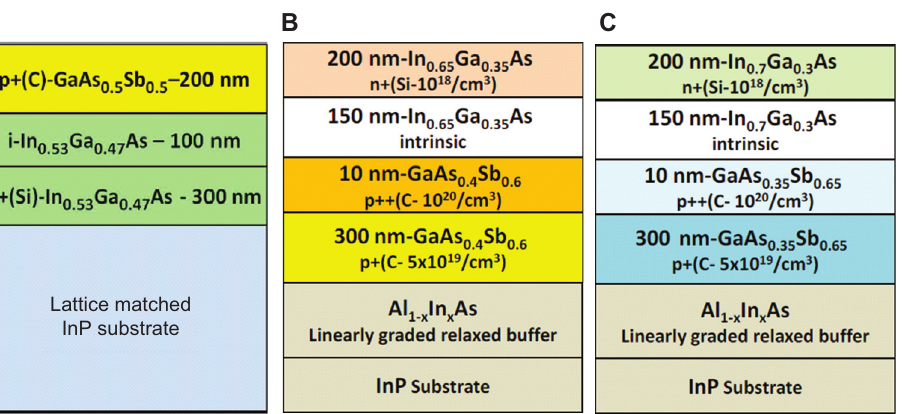
Sb /In Ga As staggered gap TFET structures with different alloy compositions. (A) GaAs y 1-y x 1-x of 0.5 eV; (B) GaAs Sb /In Ga As structure shows an E beff 0.4 0.6 0.65 0.35 values are from simulation. Reprinted from Ref. [9] and Ref. [15], with permission, from IEEE. beff